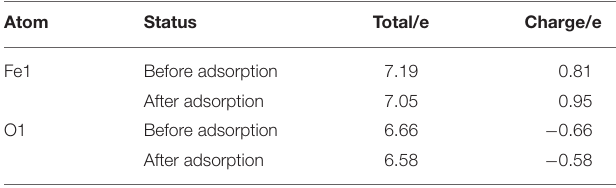
TABLE 5 | Atom population of Pb(OH) + on the ilmenite